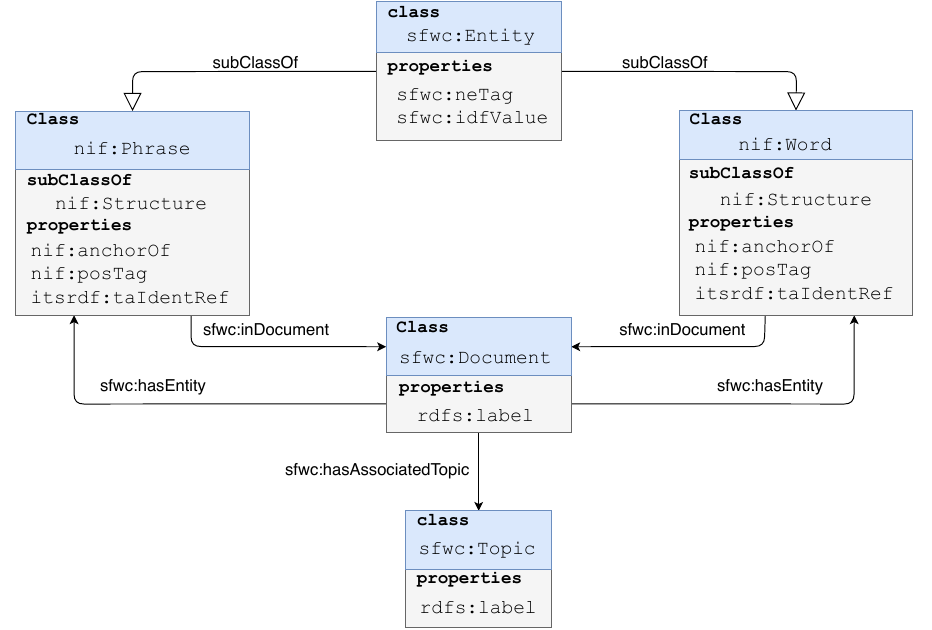
Figure 2. The Knowledge Representation Schema to describe the relationship between a noun and a